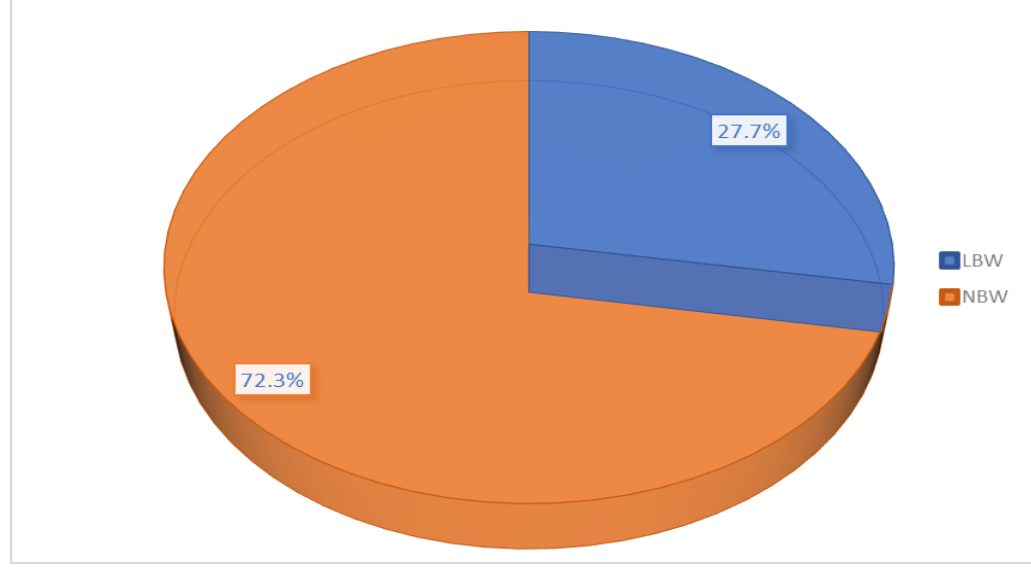
Fig. 1. Pie diagram showing the proportion of low birth weight (n=350).